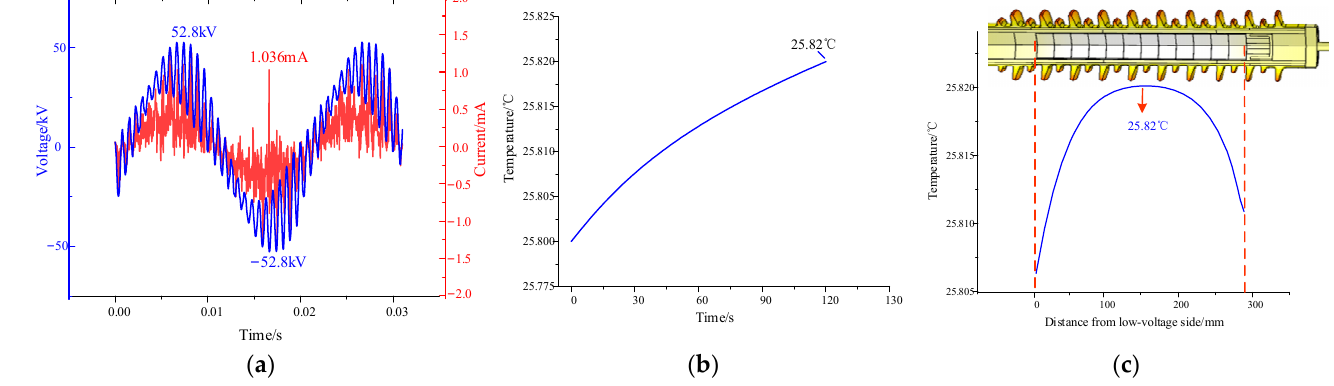
Figure 17. The current and temperature distribution of the arrester. ( a ) High-harmonic overvoltage and current. ( b ) Temperature variation of the arrester. ( c ) Temperature distribution of the valve column.